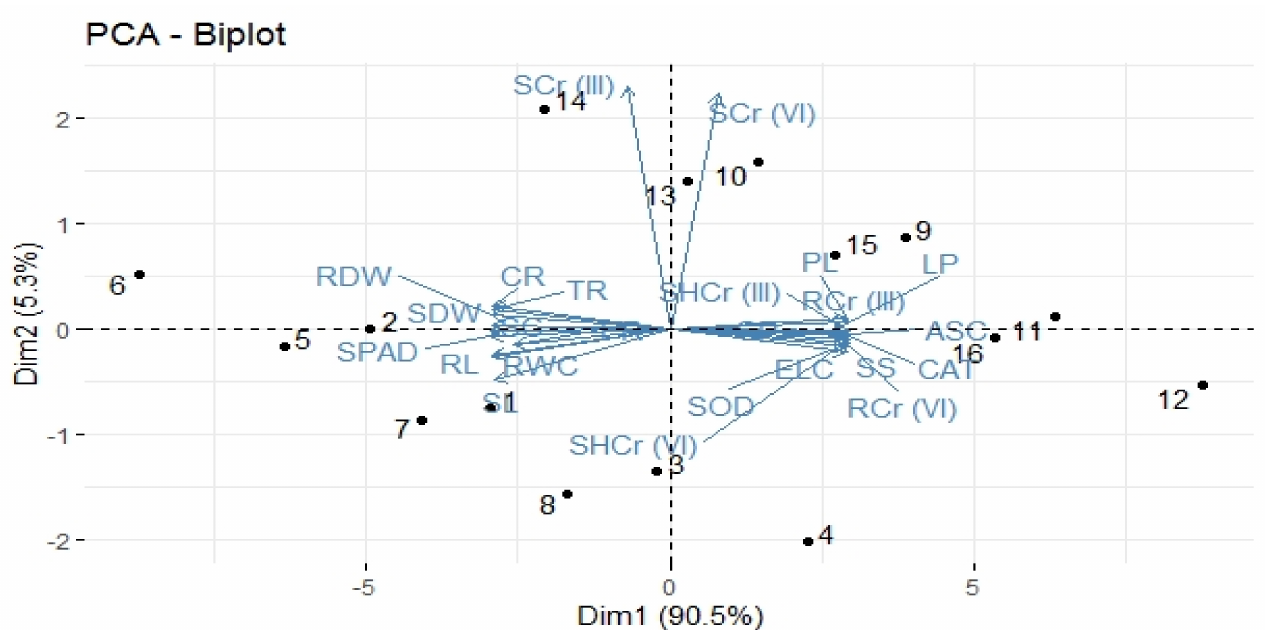
Figure 4. Principal component analysis (PCA) showing biplot (score and loading) of different attributes of maize cultivars. Score plot represents separation of treatments, such as Kasur soils (0% biochar) (1) NK − 8441, (2) P − 1543, (3) NK − 8711, (4) FH − 985; (3% biochar) (5) NK − 8441, (6) P − 1543, (7) NK − 8711, (8) FH − 985; Sialkot soils (0% biochar) (9) NK − 8441, (10) P − 1543, (11) NK − 8711, (12) FH − 985; (3% biochar) (13) NK − 8441, (14) P − 1543, (15) NK − 8711, (16) FH − 985. Loading plot shows the loading of each studied variable (arrows) and the arrow length approximates their variance, whereas the angles between them represent their correlation. The abbreviations are as follows: Shoot length: SL, Root length: RL, Shoot dry weight: SDW, Root dry weight: RDW, Chlorophyll contents: SPAD, Photosynthetic rate: PR, Transpiration rate: TR, Stomatal conductance: SC, Lipid peroxidation: LP, Proline contents: PL, Total carotenoids: CR, Soil Cr lll: SCrlll, Shoot Cr III: SHCrIII, Root Cr III: RCrIII, Soil Cr VI: SCrVl, Shoot Cr VI: SHCrVI, Root Cr VI: RCrVI, Relative water contents: